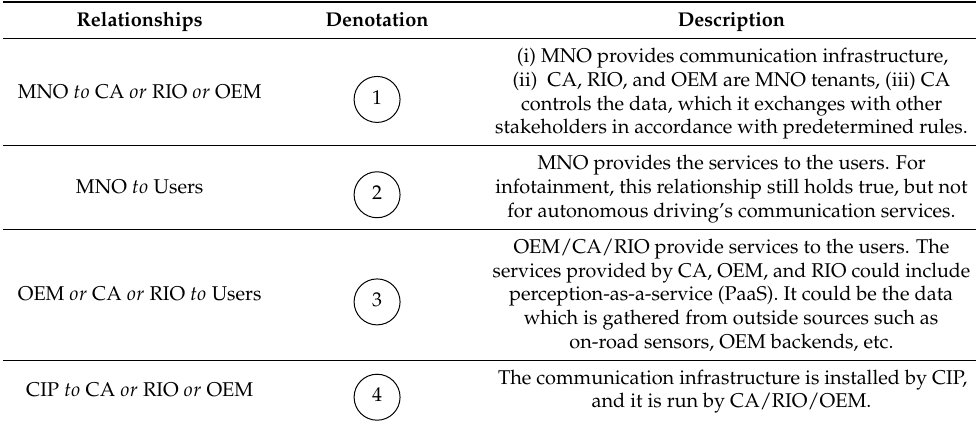
Table 3. Inter-stakeholders relationship for